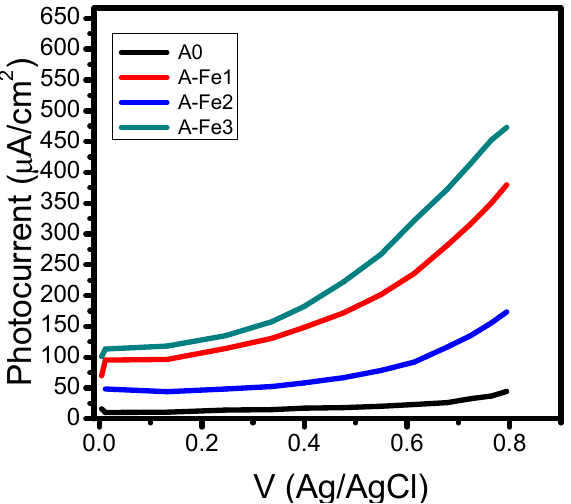
Figure 4. LSV of PANi A0, A-Fe1, A-Fe2 and A-Fe3 films. The film acted as the working electrode in the PEC while Ag/AgCl and Pt mesh acted as a reference and Counter electrode respectively; illuminated with light (100 W of halogen lamp). A solution of HCl adjusted pH to 2 was used in Na 2 SO 4 electrolyte. The films A0, A-Fe1, A-Fe2 and A-Fe3 were further investigated for PEC activity through chronoamperometry under switching the light on/off every 60 s (Figure 5). As expected, the PANi film showed the lowest current density of 100 μ A/cm 2 in the dark and 125 μ A/cm 2 under light illumination. In contrast, the optimized film A-Fe3 showed the highest current of 120 μ A/cm 2 in the dark and 520 μ A/cm 2 , marking a gain of more than 400 μ A/cm 2 due to light illumination. All of the above films demonstrated reproducible currents and durability over the time range that was used (0–200 s). It was also observed at the end of the test that the A-Fe3 film had lost only 10% of its initial photocurrent. Thus, the presence of MnFe 2 O 4 strongly enhanced the PEC performance toward the OER. A-Fe3 and PANi A0 films were further examined for long-term stability and durability for more than 900 s (Figure 6).